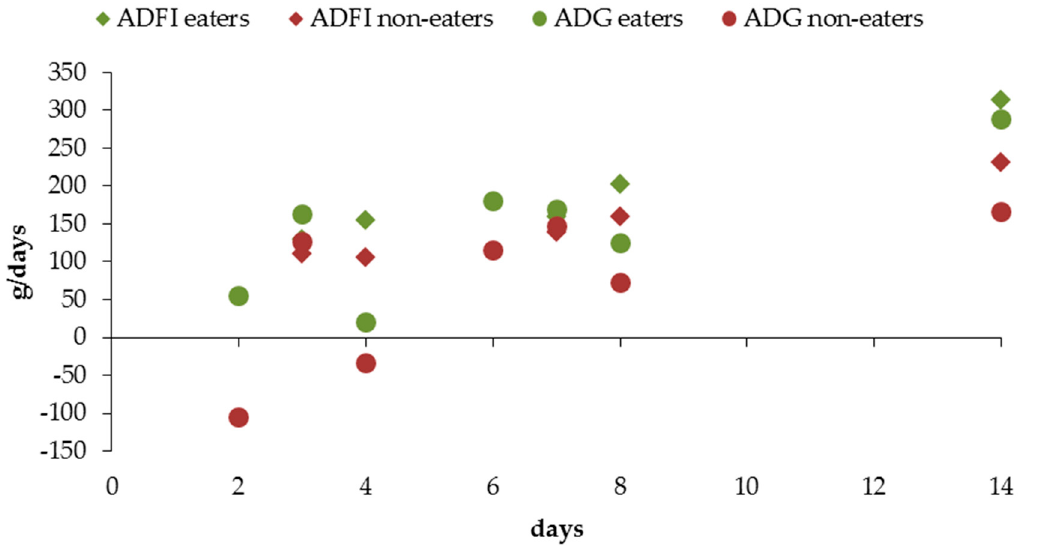
Figure 3. Post-weaning feed intake (average daily feed intake, ADFI, ♦ ) and growth (average daily gain, ADG, ● ) of piglets categorized as creep-feed eaters (eaters, green), and non-creep-feed eaters (non-eaters, red). Adapted from References [176–178,180,181].